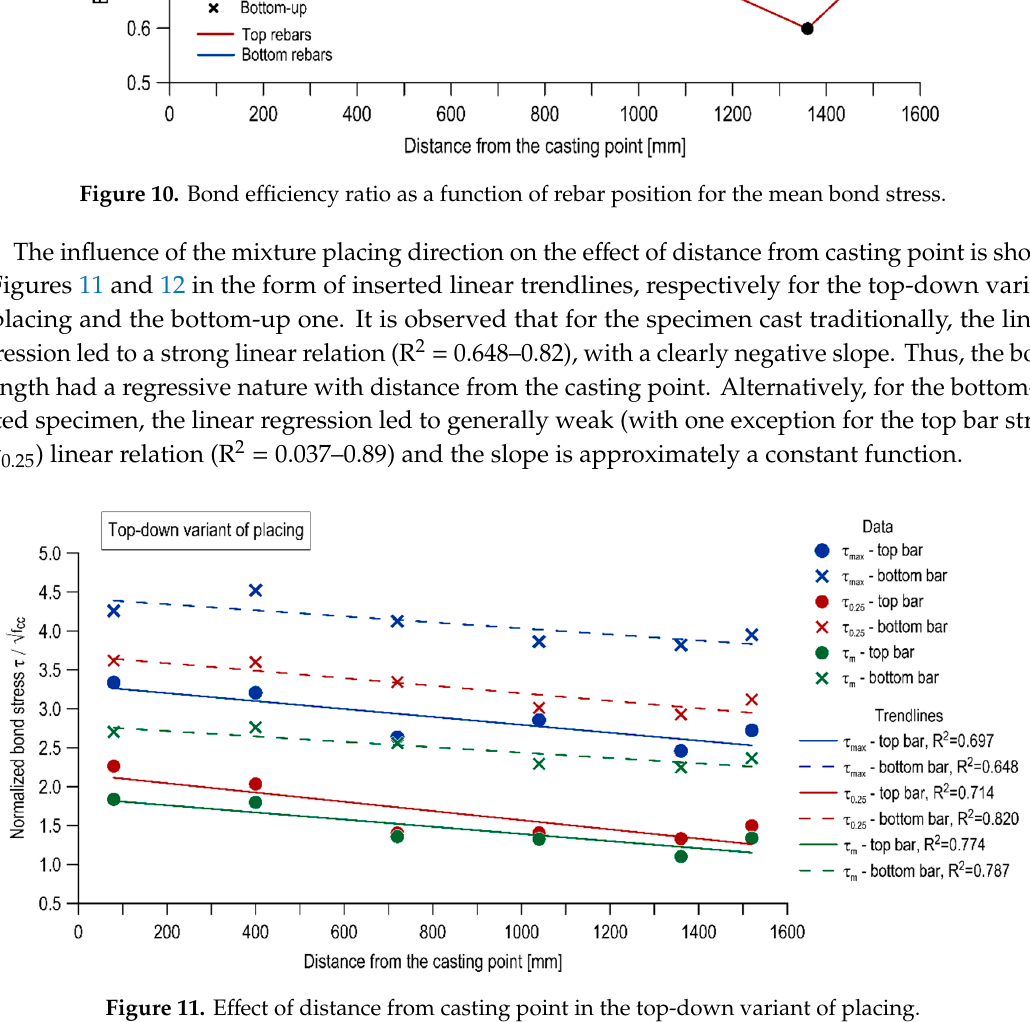
Figure 10. Bond efficiency ratio as a function of rebar position for the mean bond stress.